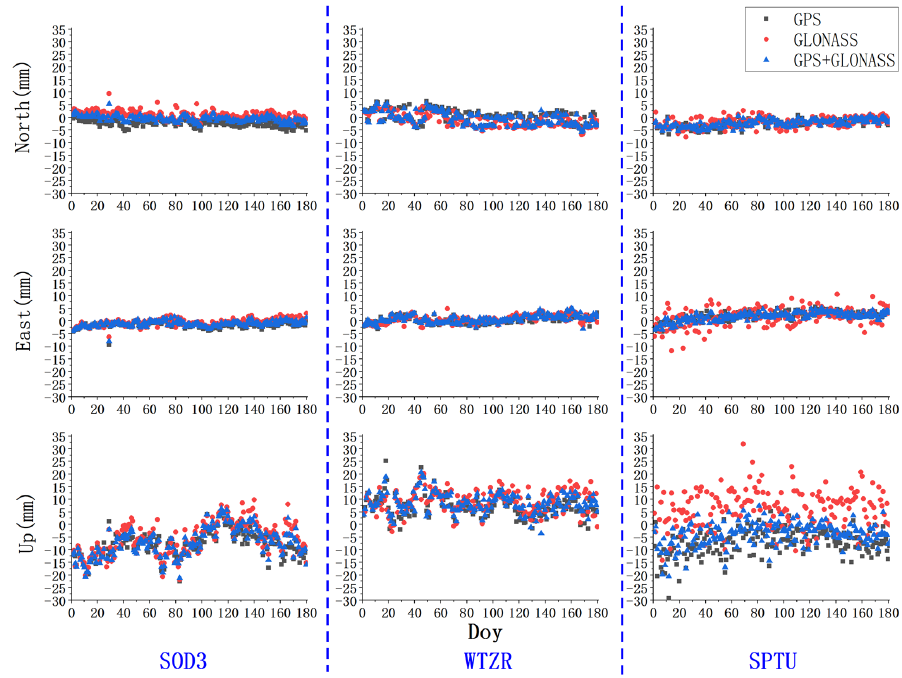
Figure 8. The coordinate error series of station SOD3, WTZR, and SPTU estimated with DD pro- cessing.